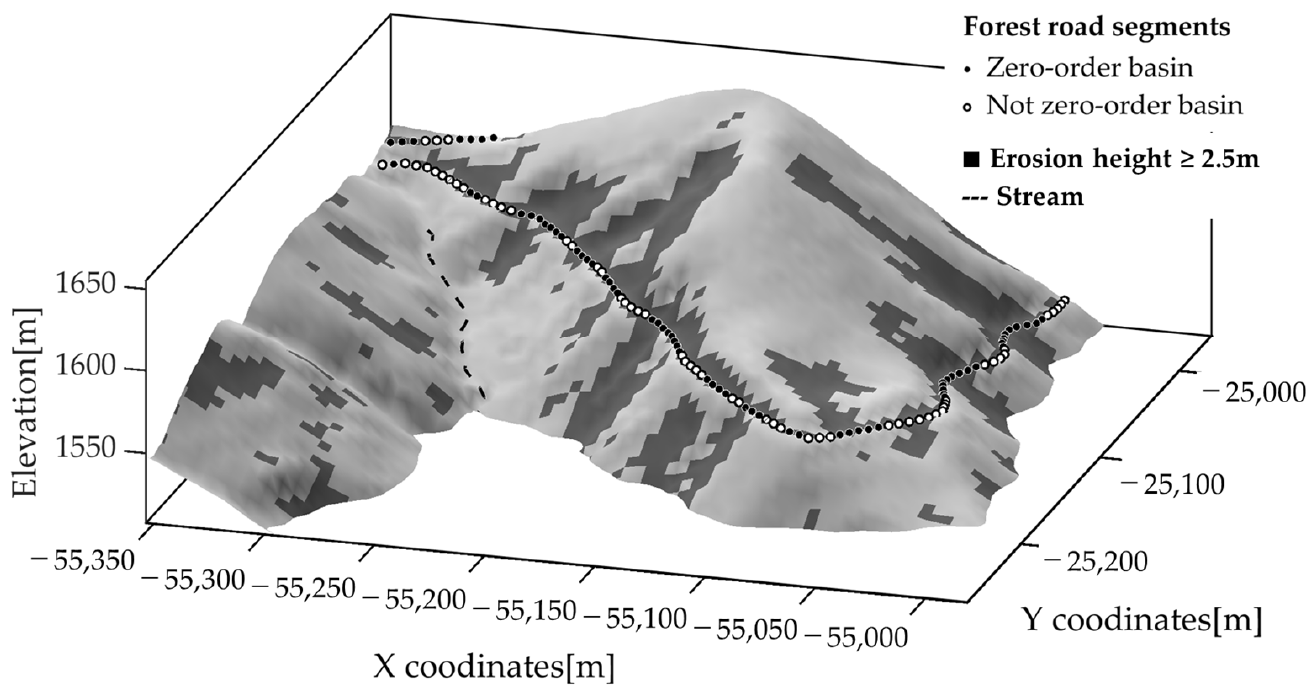
Figure 6. Image of a forest road segment that falls into the zero-order basin category. Note: The points in the figure represent the center coordinates of the segment.